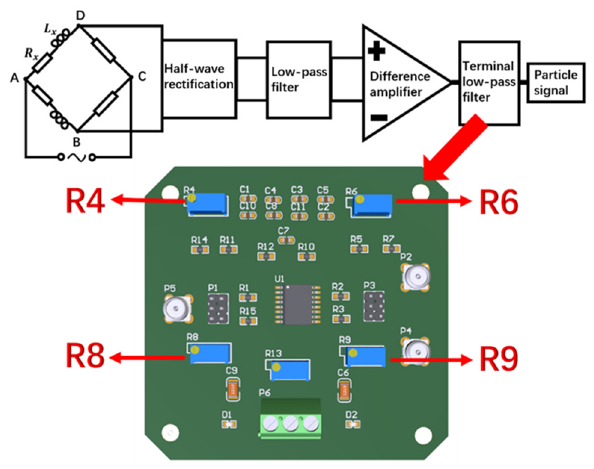
Figure 14. Terminal UAF42 low pass filter.